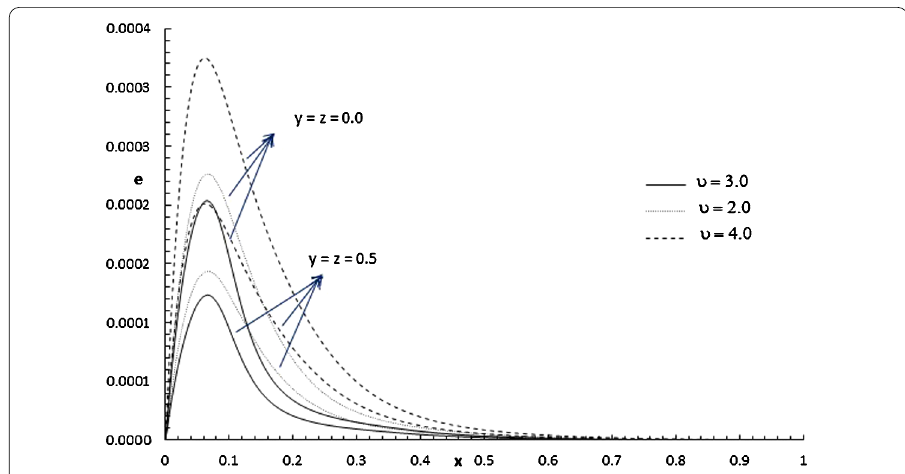
Figure 4 The cubical dilatation distribution for various values of heat source speed